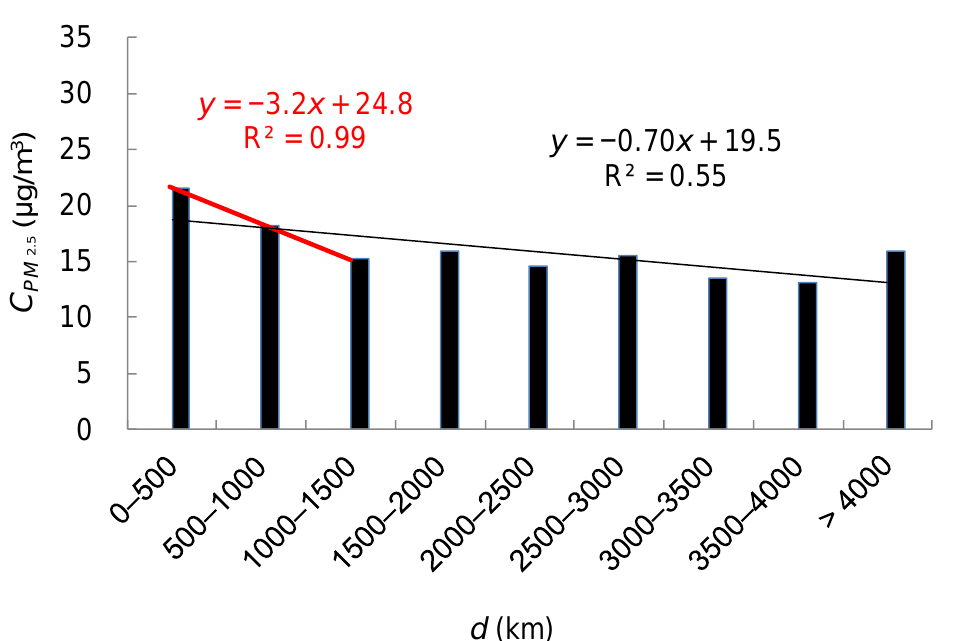
Figure 4. Relationship between mean PM 2.5 concentration ( C PM and distance between the Taipei station and centre of the continental high-pressure system ( d , km).